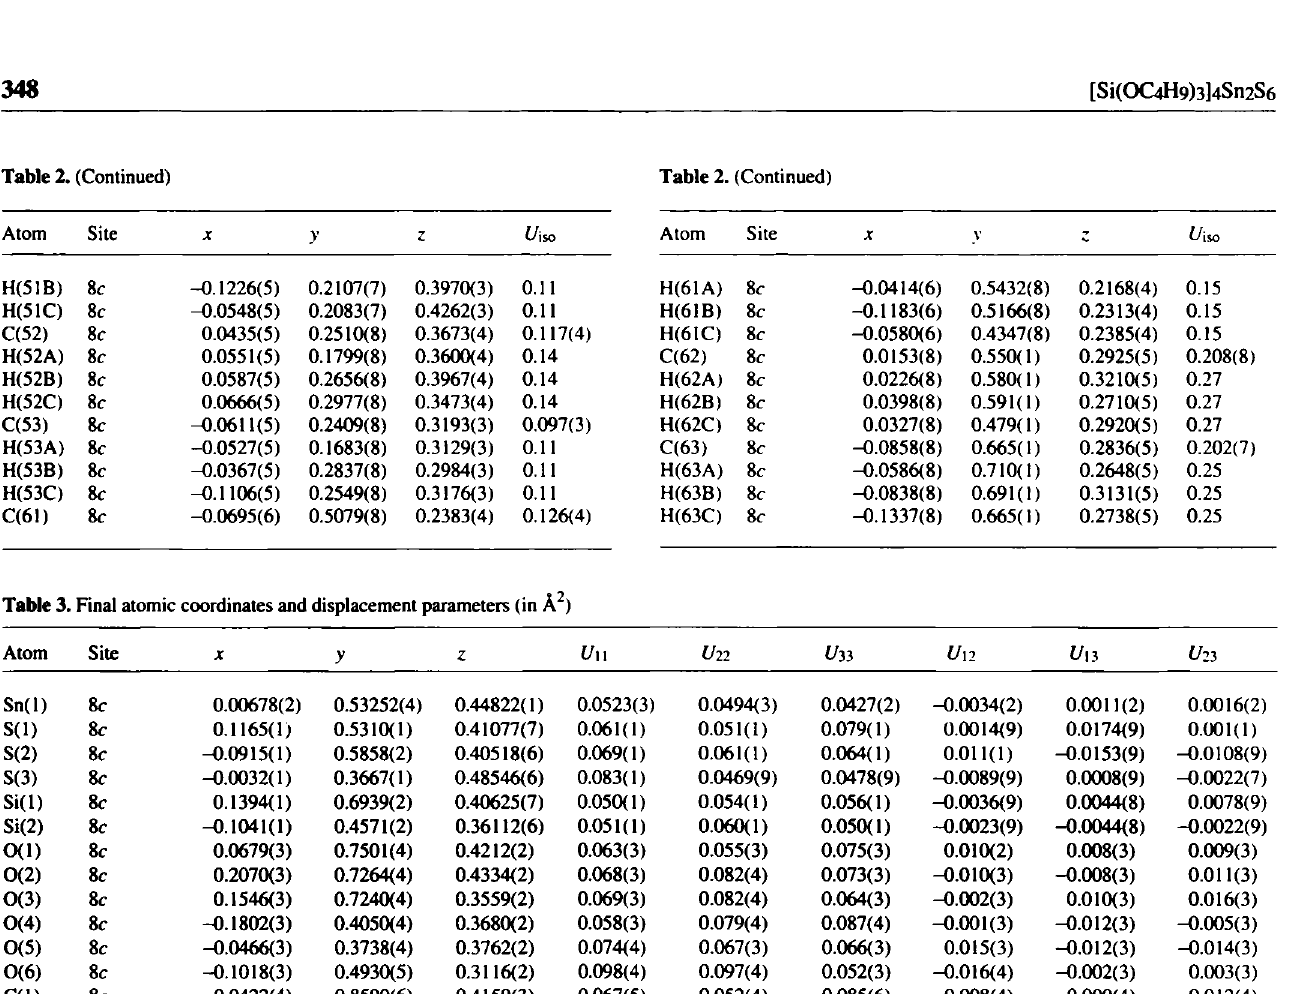
Table 3. Final atomic coordinates and displacement parameters (in